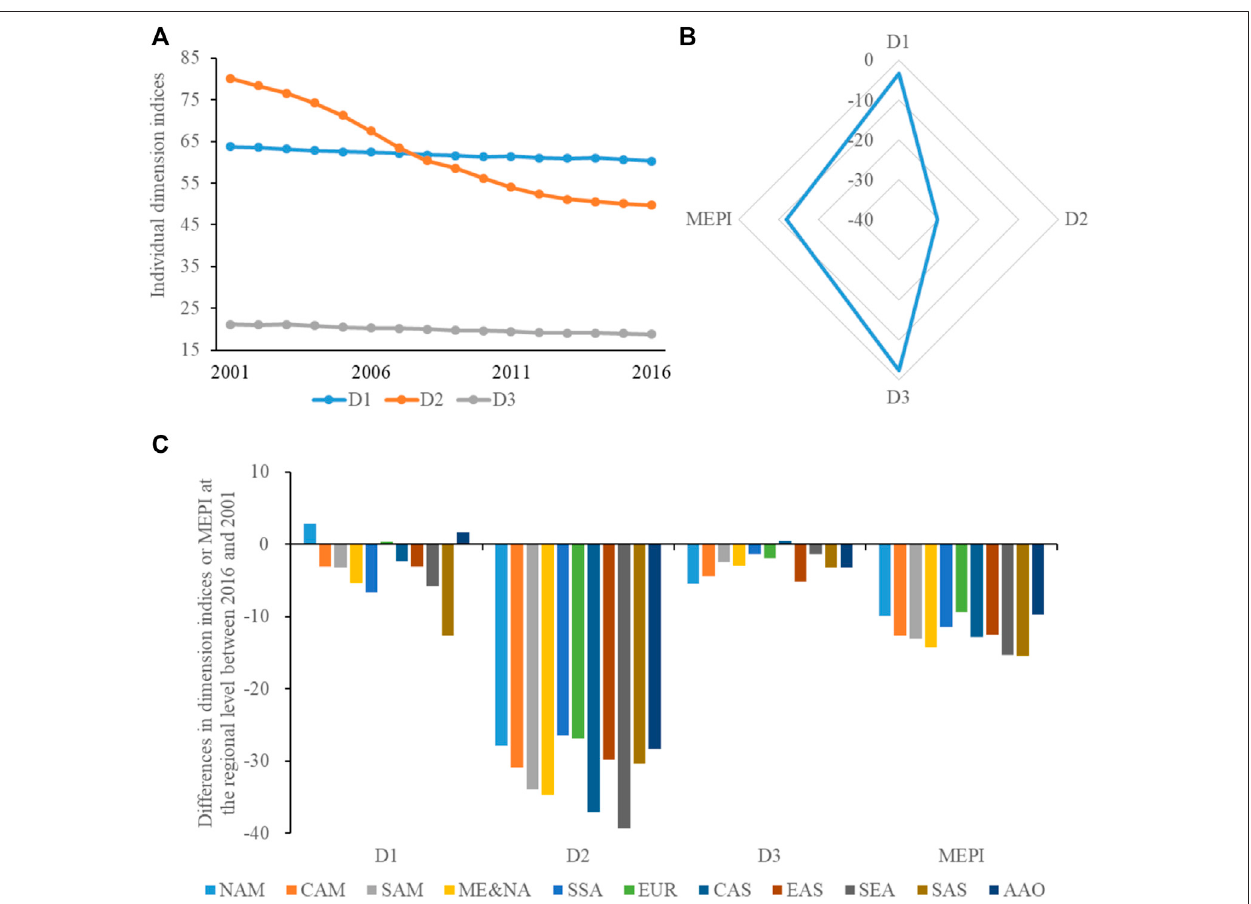
FIGURE3| Change indimension indicesortheMEAI. (A) Changesindimensionindicesfrom2001to2016 at theglobal level. (B) Differencesindimensionindices between 2016 and 2001 at the global level. (C) Differences in dimension indices and the MEAI between 2016 and 2001 at the regional level. D1 is the abbreviation for energyavailability,D2forenergyaffordability,andD3forenergyef fi ciency.Apositivevalueindicatesanincreaseintheindexfrom2001to2016,whereasanegativevalue indicates a decrease in the index from 2001 to 2016.